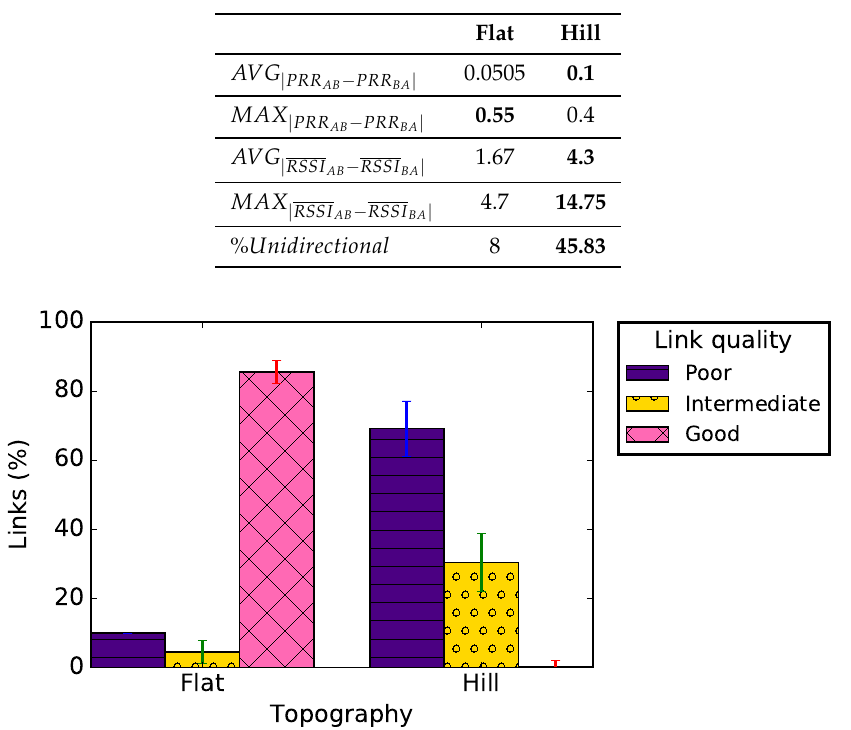
Table 4. Link asymmetry for flat and hill environments.